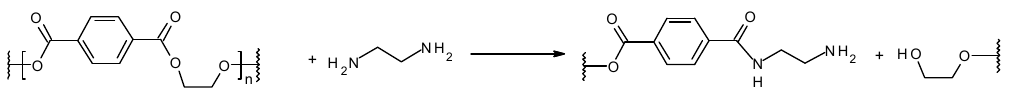
Table 3. Aminolysis conditions of the poly(ethylene terephthalate) (PET) nanofiber mats and elemental analysis for blank PET and aminated PET